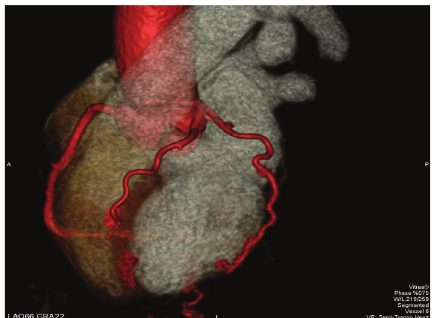
Figure 5: Three dimensional reconstruction exhibiting the interar- terial course of the left main coronary artery as presented in Case